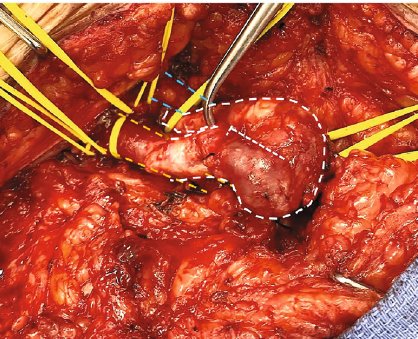
Figure 2: Dissection of the arteriovenous fi stula and pseudoaneurysm (white borders). Top left is the inguinal ligament, orange borders highlight the common femoral artery, and blue borders highlight femoral